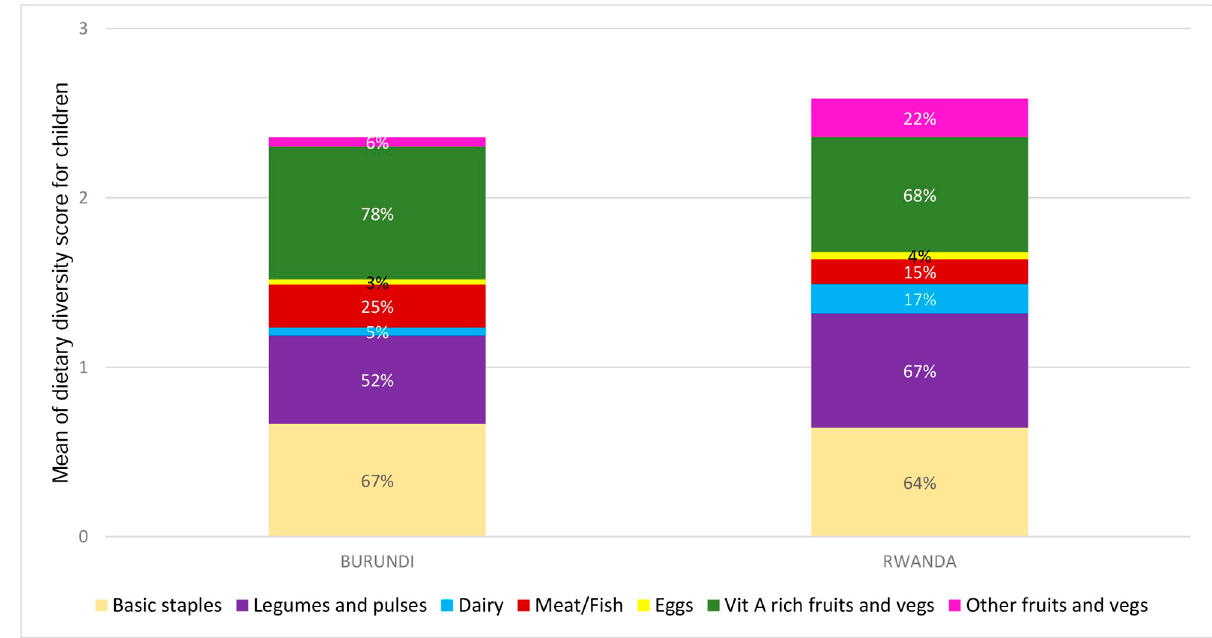
Fig 2. Mean dietary diversity and food groups’ consumption in children aged 6–23 months in Burundi and Rwanda, DHS 2010.